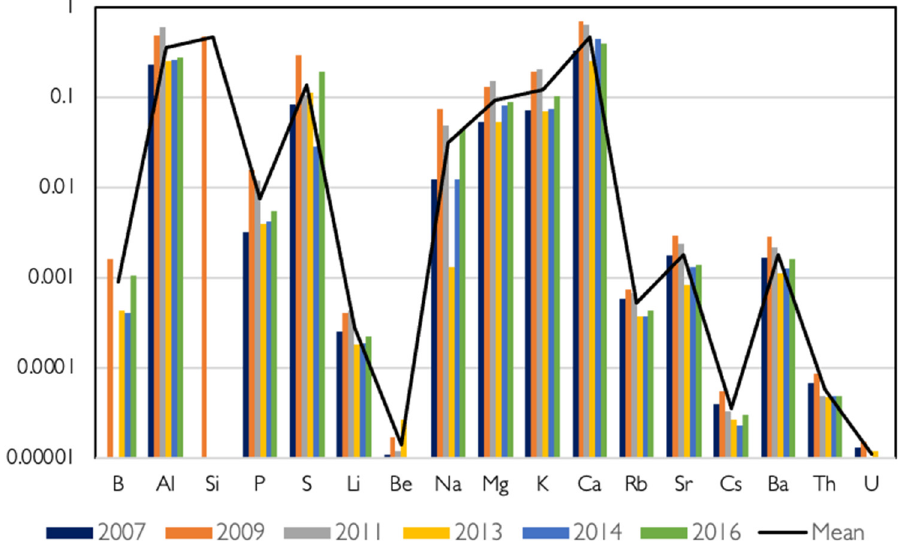
Figure 12. Percentage of mass content of chemical elements of global distribution in the aerosol particles over semi-arid lands of Kalmykia in different years of 2007–2016. Black line is the averaged percentage of the indicated element for all years. We used the data on the elemental composition of aerosol in Kalmykia, published, in particular, in Table 4 [61].